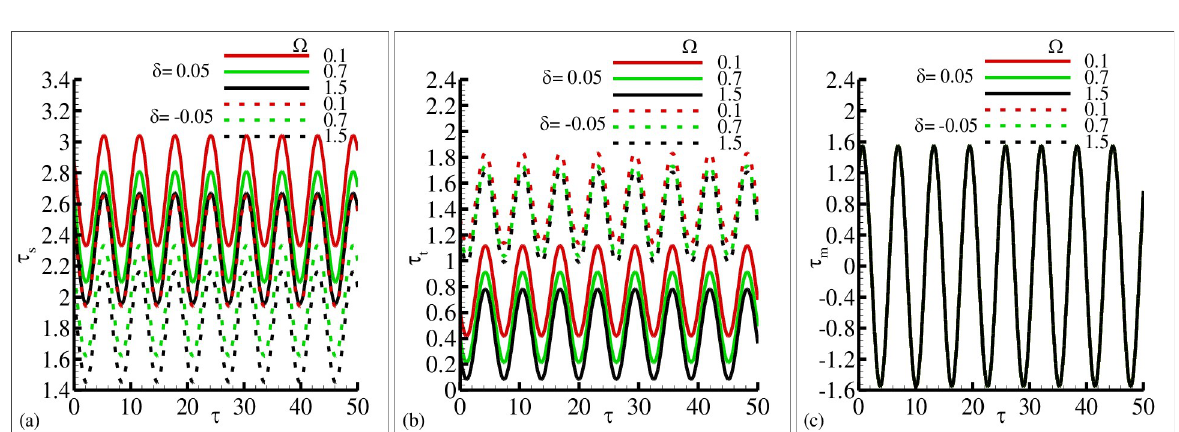
Fig 8. The graphical results of (a) τ parameters γ = 0.8, ξ = 0.3, Pr = 7.0, and λ = 5.1.